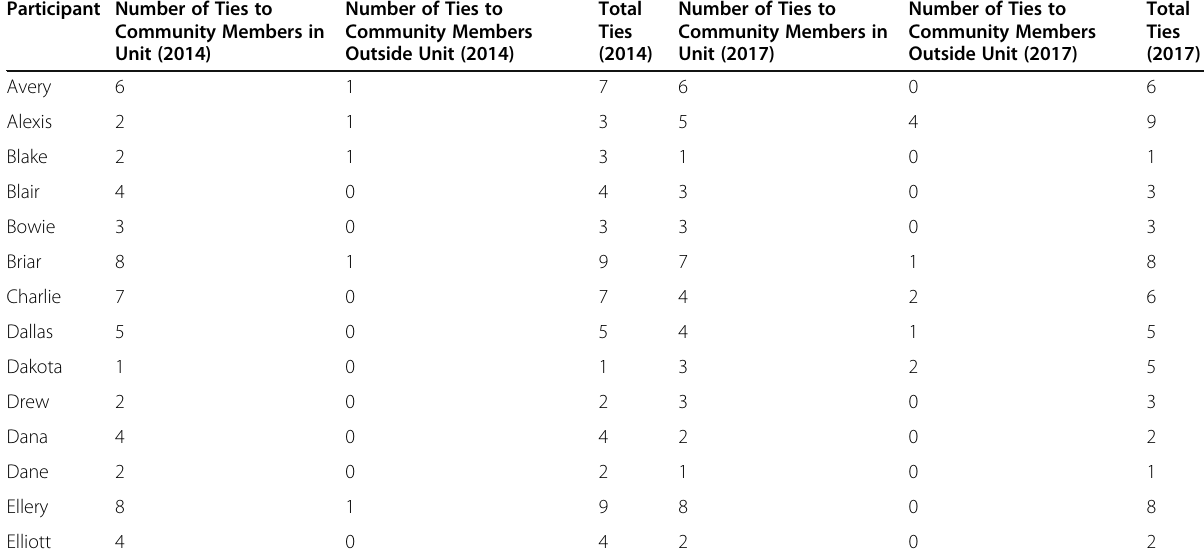
Table 2 Number of Community Members with whom Participants Talked about Teaching in 2014 and 2017 Participant Number of Ties to Community Members